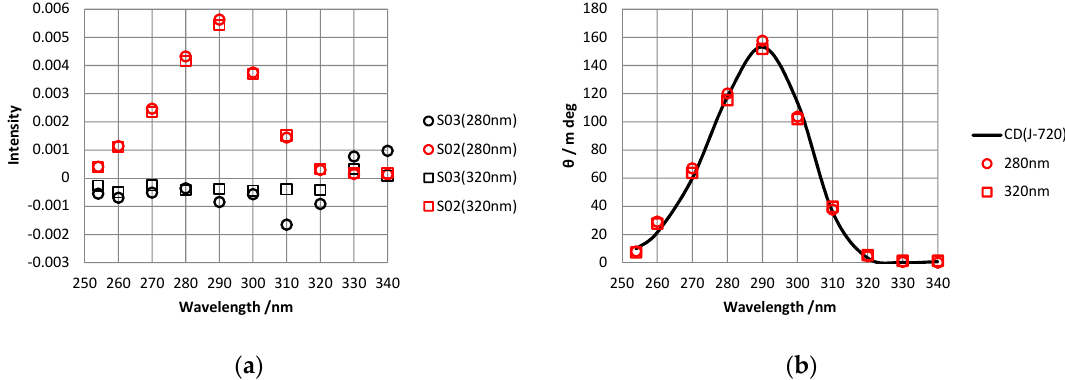
Figure 3. ( a ) Circular dichroism (CD) and linear dichroism (LD) spectra of (1 S )-(+)-10-comphorsulfonic acid ammonium salt (CSA) in distilled water obtained by retardation domain analysis. We assume that S02 (red) is equal to CD and S03 (black) is equal to LD. The wavelength settings were 280 nm (circles) and 320 nm (squares). ( b ) CD spectrum from a commercial CD spectrometer (black line) and comparison with CD values via retardation domain analysis (red circles and